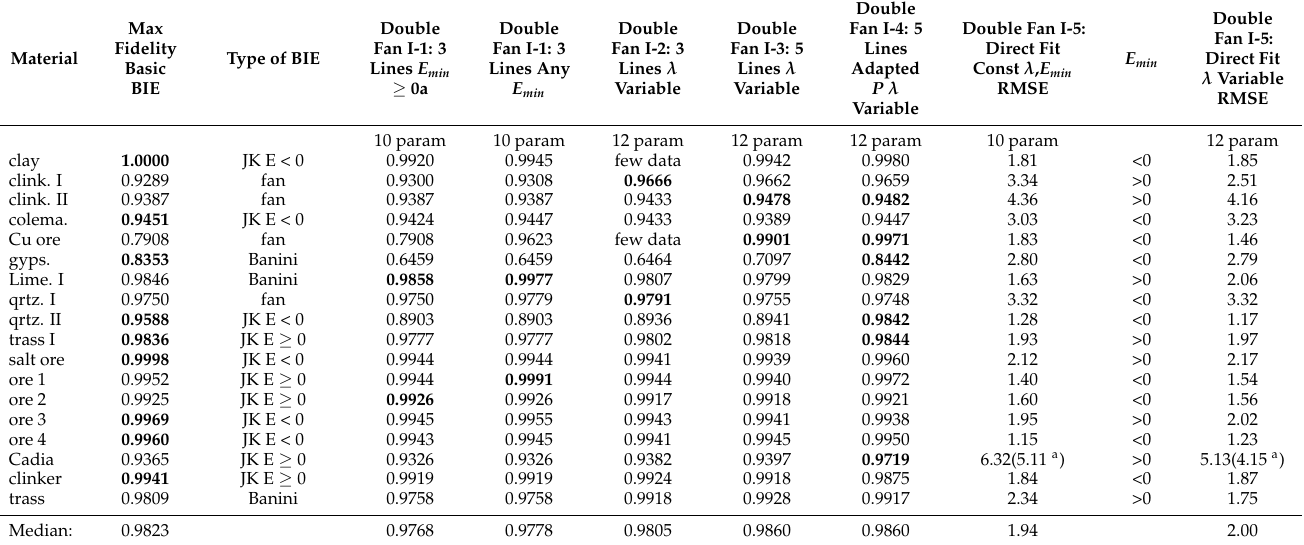
Table 6. Fidelities, R 2 and RMSE (for direct fits, I-5) for improved versions of double fan BIE, compared to results for basic BIE in Table 5, calculating R 2 in t 10 vs. E (cid:48) cs space. Bold number: highest R 2 -value for that material.